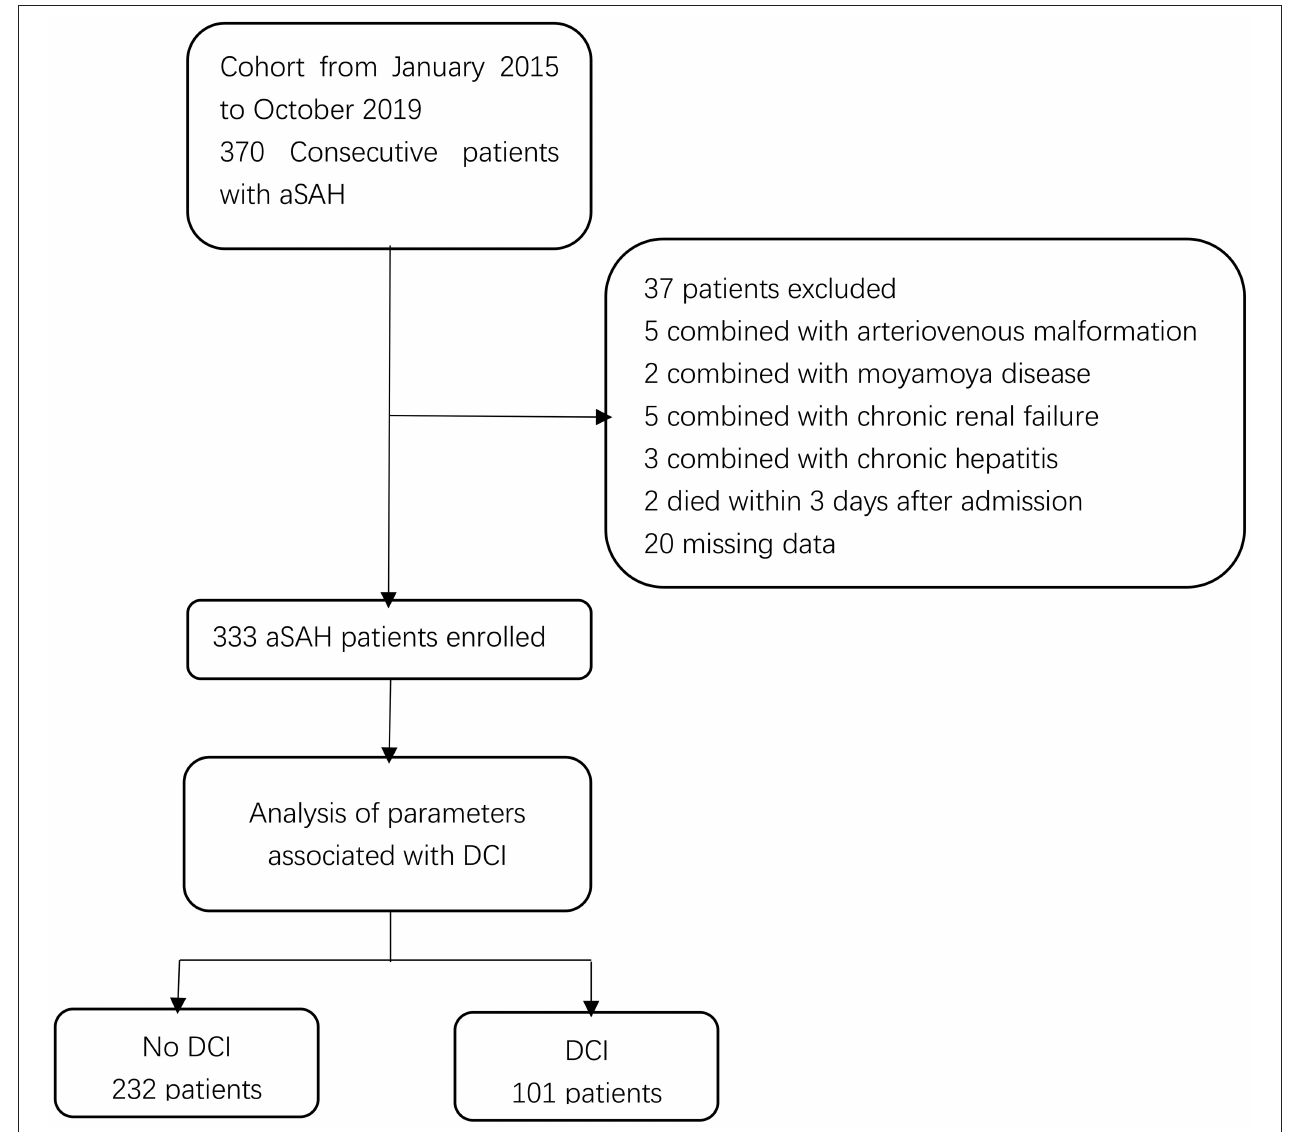
FIGURE 1 | Flow chart of study patients. aSAH, aneurysmal subarachnoid hemorrhage; DCI, delayed cerebral ischemia.